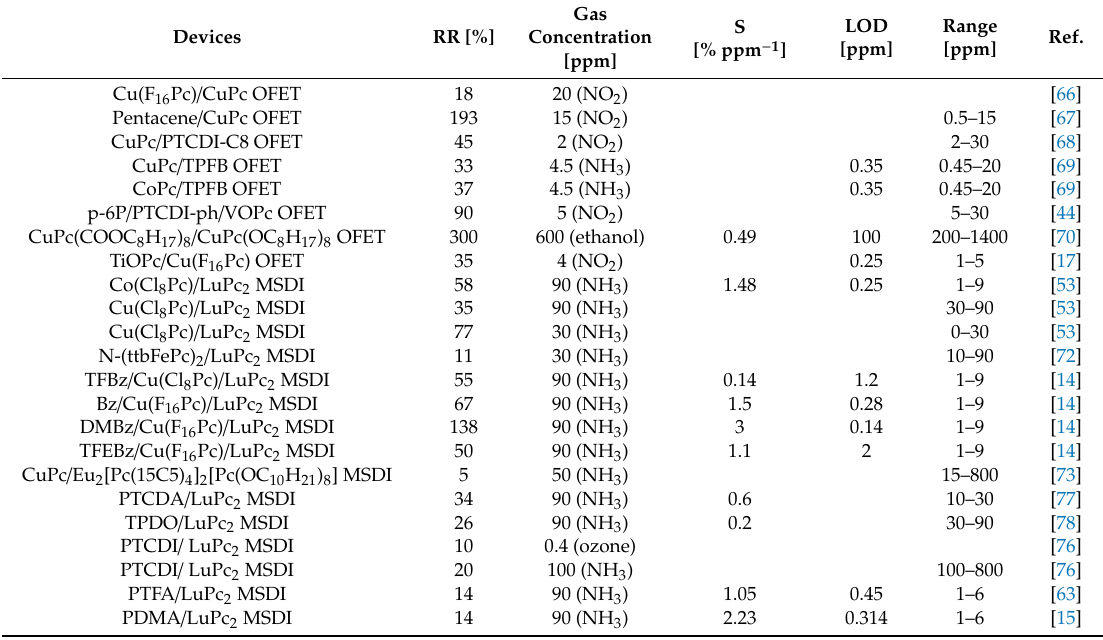
Table 1. Comparison of gas sensing properties of di ff erent OFET and MSDI devices incorporating MPc-based